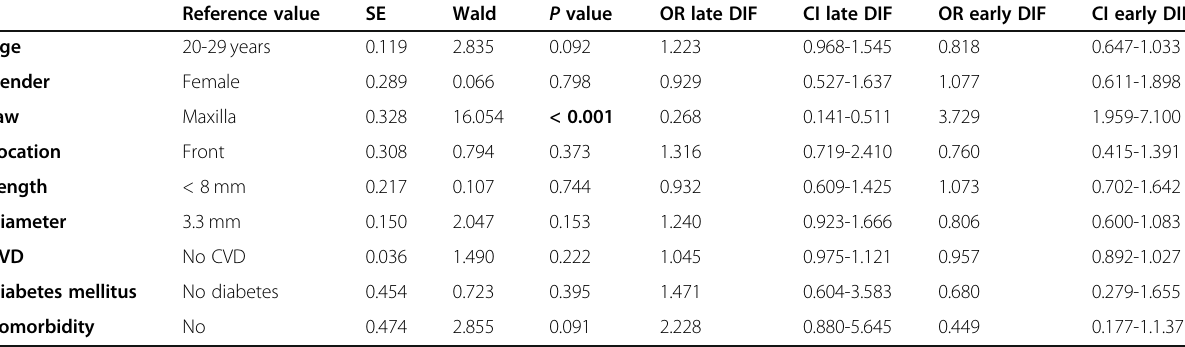
Table 3 Multivariate logistic regression